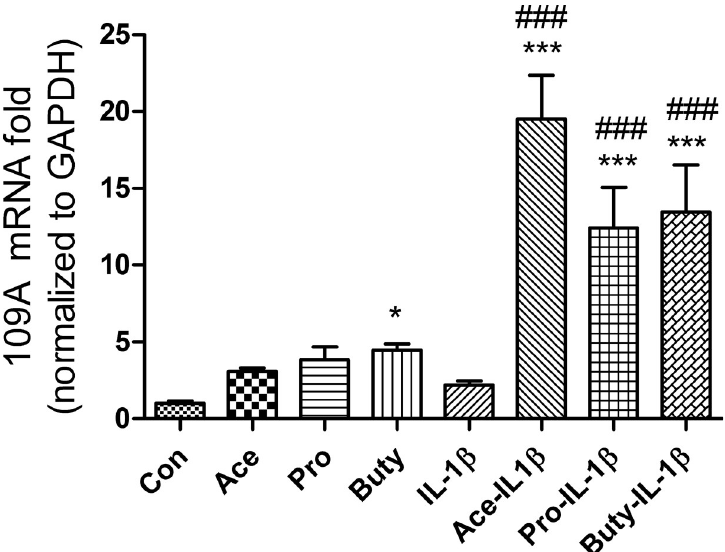
Fig 7. SCFAs increase G protein-coupled receptors 109A (GPR109A) mRNA expression in response to IL-1 β stimulation in human immature enterocytes. H4 cells were pretreated with or without 20 mM of SCFAs for 30 min before IL-1 β stimulation (1ng/ml for 4h); or treated with 20 mM of SCFAs alone. GPR109A mRNA levels were determined by real time RT-PCR. Data are represented as the mean ± SEM of three independent experiments, n = 3. One -way ANOVA and Tukey post hoc tests were used for statistic. Differences compared to the control group were considered significant at ��� p < 0.001; differences compared to the IL-1 β group were considered significant at ### p < 0.001.